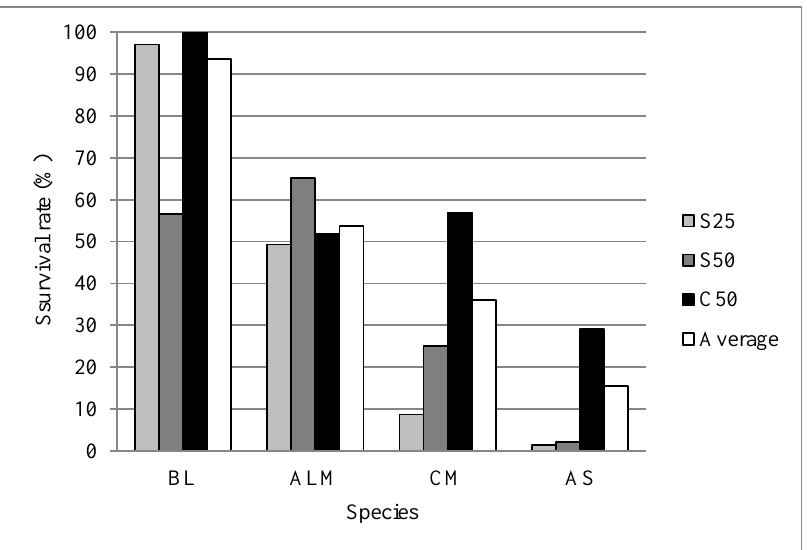
Figure 2. Survival rate of the studied tree species in individual groups of research plots. Notes: BL — black locust; ALM — ash-leaf maple; CM — common maple; AS — American ash; S25 — combustion waste covered with sewage sludge, 25 cm thick; S50 — combustion waste covered with sewage sludge, 50 cm thick; C50 — clay-covered combustion waste. each). Compared to other species, the ash showed the smallest measurements of DBH.